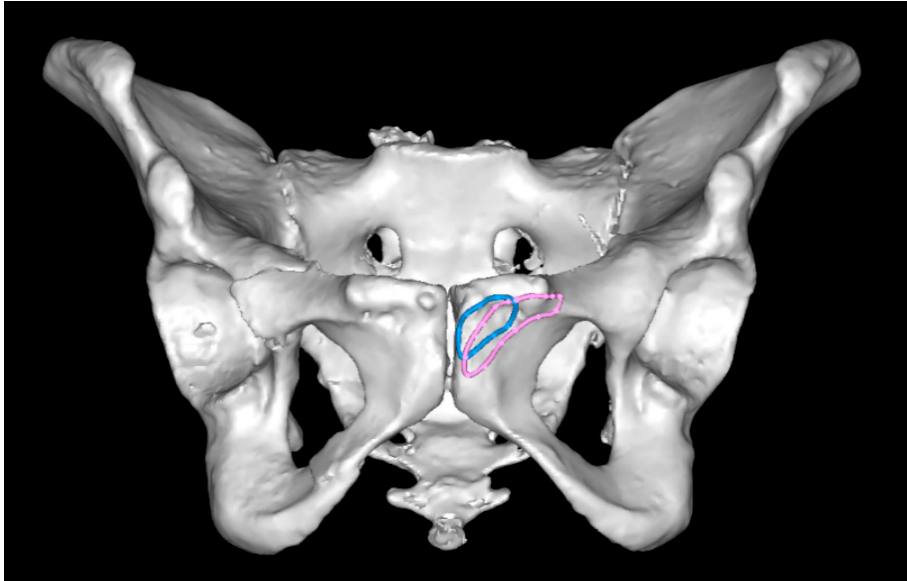
Figure 5. The region of entry points was located more laterally in females (pink) when compared to males (blue).